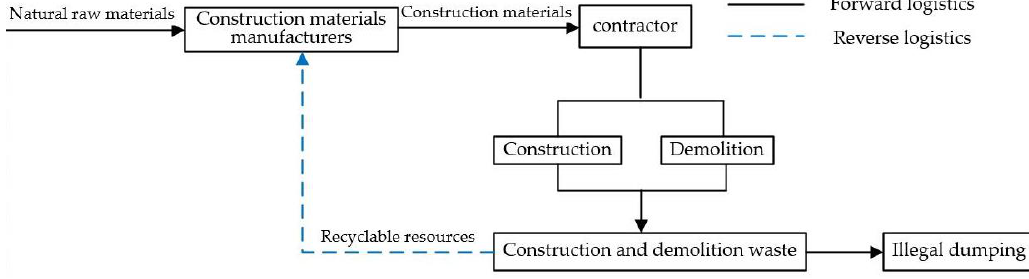
Figure 1. The CDW recycling supply chain.